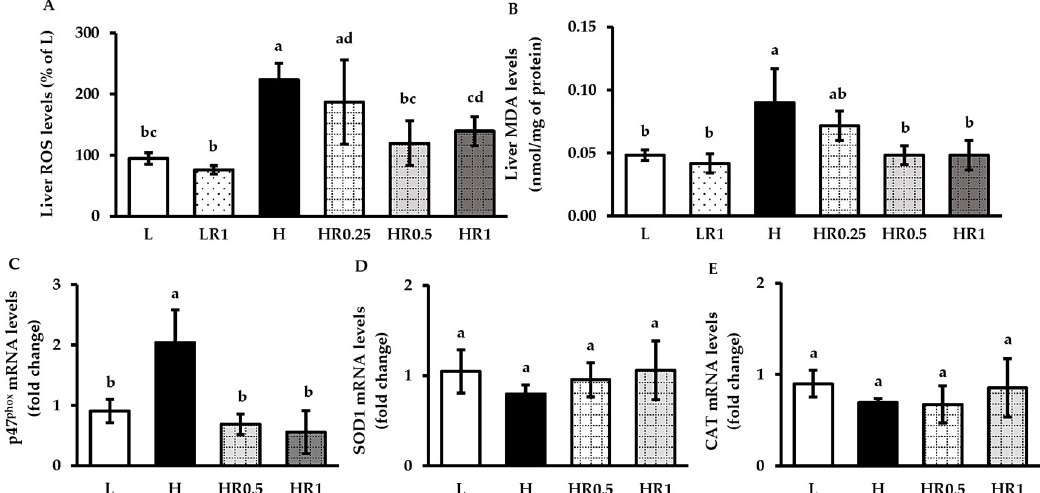
Figure 5. Effects of RRBE on hepatic oxidative stress markers in mice fed with experimental diets: ( A ) liver ROS levels; ( B ) liver MDA levels; ( C ) liver p47 phox mRNA levels; ( D ) liver SOD1 mRNA levels; ( E ) liver CAT mRNA levels. Values are means ± SD; 6 mice/group. Statistically significant difference at p < 0.05 was analyzed using one-way ANOVA with Tukey’s test and is indicated by different letters above error bars. The L, LFD, and distilled water co-treated group; LR1, LFD, and high-dose (1 g/kg) RRBE co-treated group; H, HFD, and distilled water co-treated group; HR0.25, HFD, and low-dose (0.25 g/kg) RRBE co-treated group; HR0.5, HFD, and middle-dose (0.5 g/kg) RRBE co-treated group; HR1, HFD, and high-dose RRBE co-treated group.